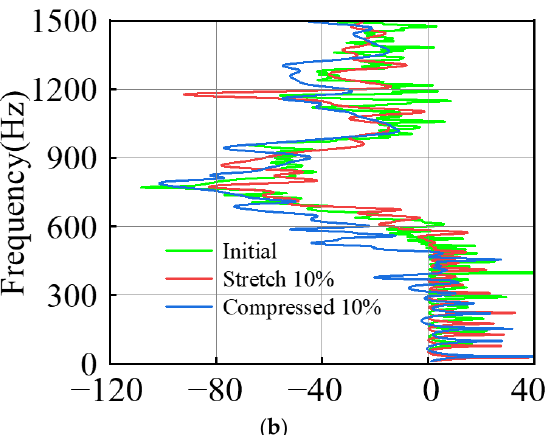
Figure 14. Influence of a 10% external load on the system: ( a ) deformation under a 10% tensile and compressive load; ( b ) transmission characteristic curve.